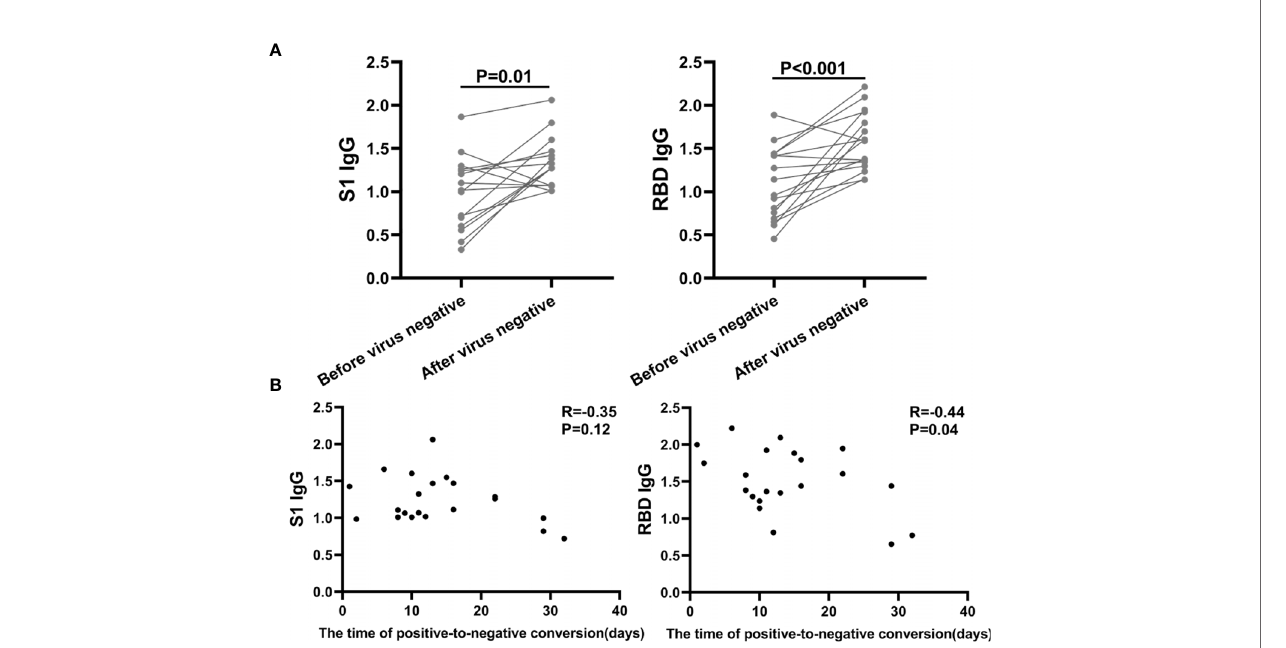
FIGURE 2 | The Time of Positive-to-negative Conversion of SARS-CoV-2 Nucleic Acid was Negatively Correlated with Antibody Titer. (A) Comparison of the titers of IgG antibodies before and after the throat swab nucleic acid turn to negative. The antibody used for analysis was obtained within 9 days before and after the virus turned negative (n = 16). (B) Correlation analysis of time of positive-to-negative conversion and IgG antibody titers (n = 21). The titers of IgG antibody against S1 protein or RBD between 8-21 days from symptom onset were collected and